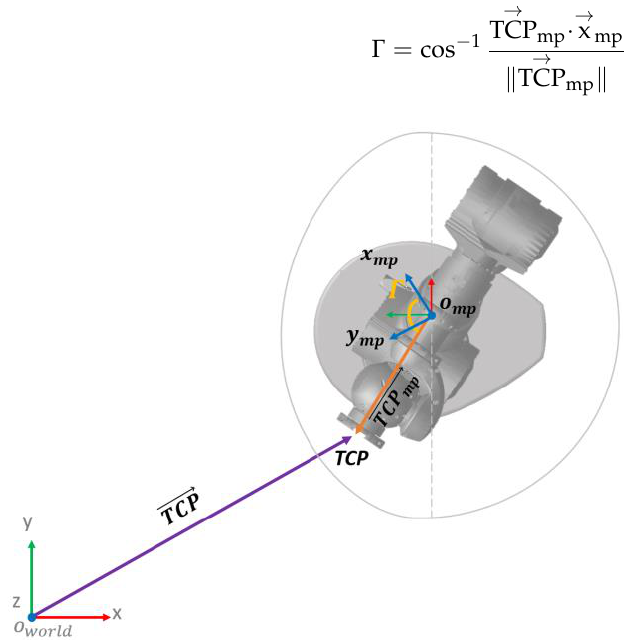
Figure 10. Angle Γ defines if the TPC is located within the critical or noncritical volume.